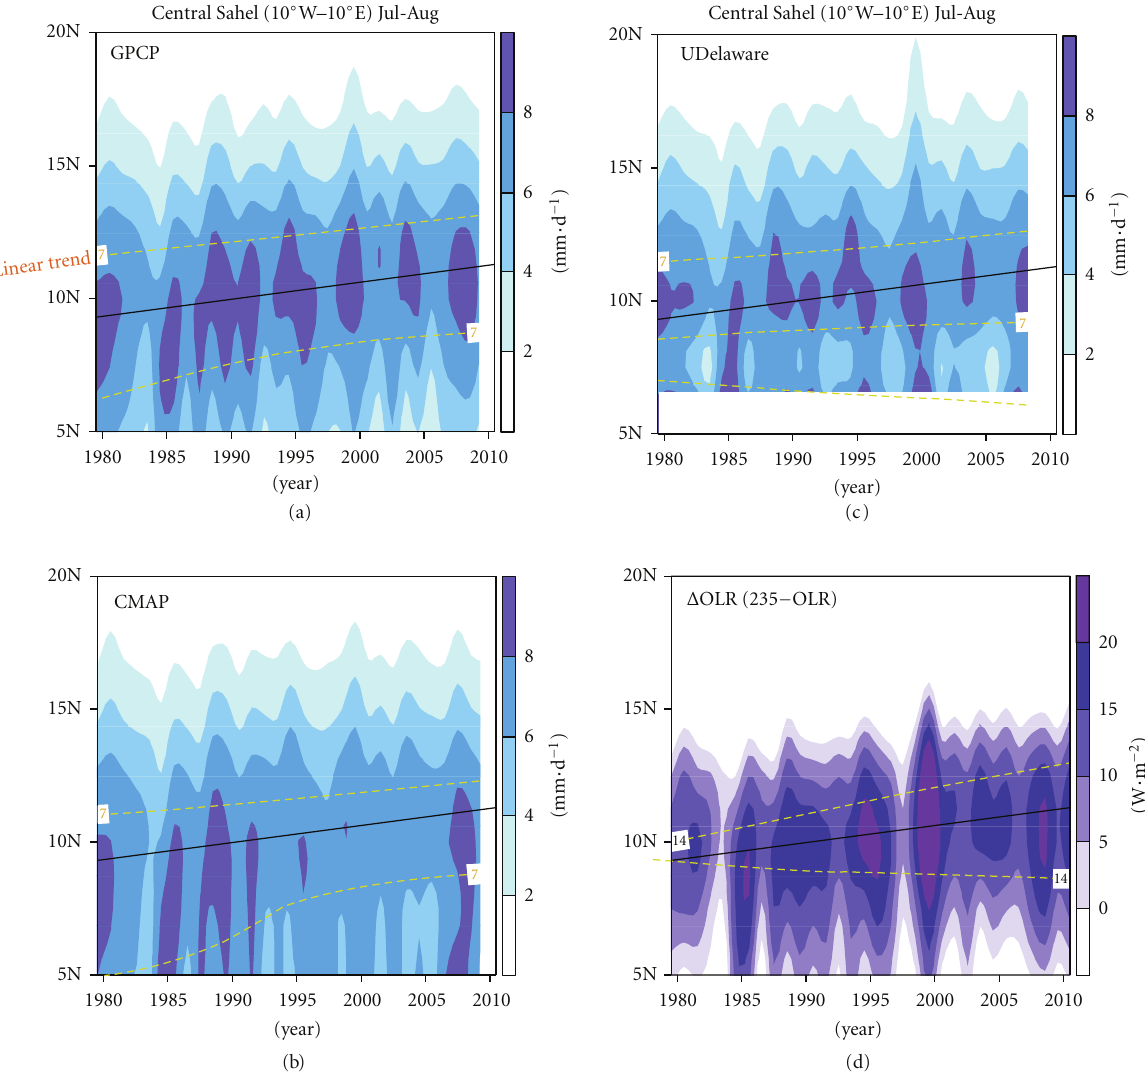
Figure 2: Latitude-time profiles of precipitation averaged between 10 ◦ W and 10 ◦ E for the July-August season, derived from (a) GPCP, (b) CMAP, (c) University of Delaware, and (d) Δ OLR ( = 235 Wm − 2 -OLR). Yellow dashed lines are linear trends of the designated value. The solid black lines indicate the average latitudinal position of maximum precipitation for the depiction of the Sahel